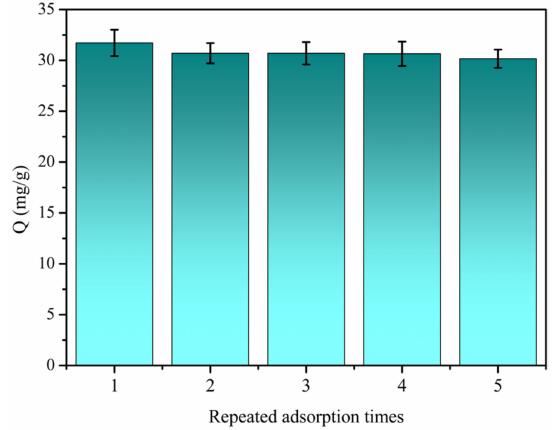
Figure 7. Regeneration rebinding performance of the